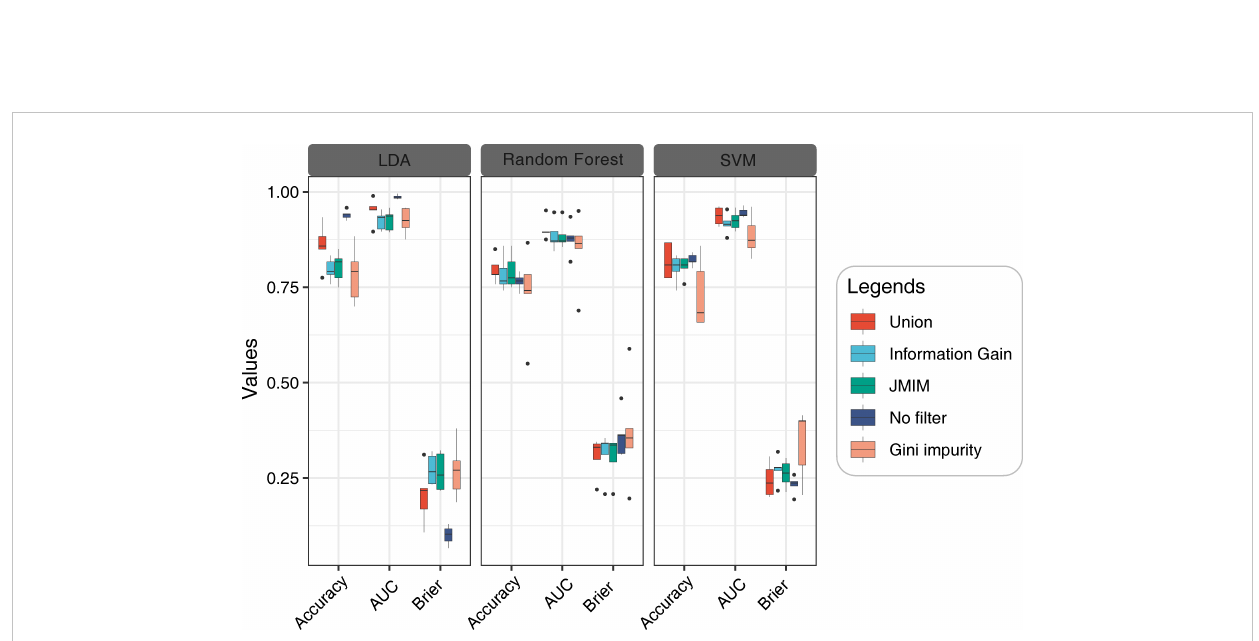
FIGURE 9 Model performance evaluation based on different feature fi ltering methods. From left to right are LDA, RF and SVM. Benchmark model performance with different fi ltering methods based on test set data using 5-fold